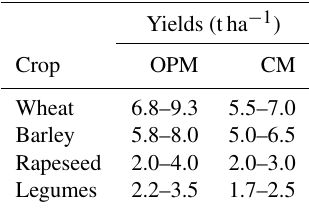
Table 6. Average crop yield (2016–2021) of OPM and conventional agricultural fields under conventional tillage (CM), as reported by